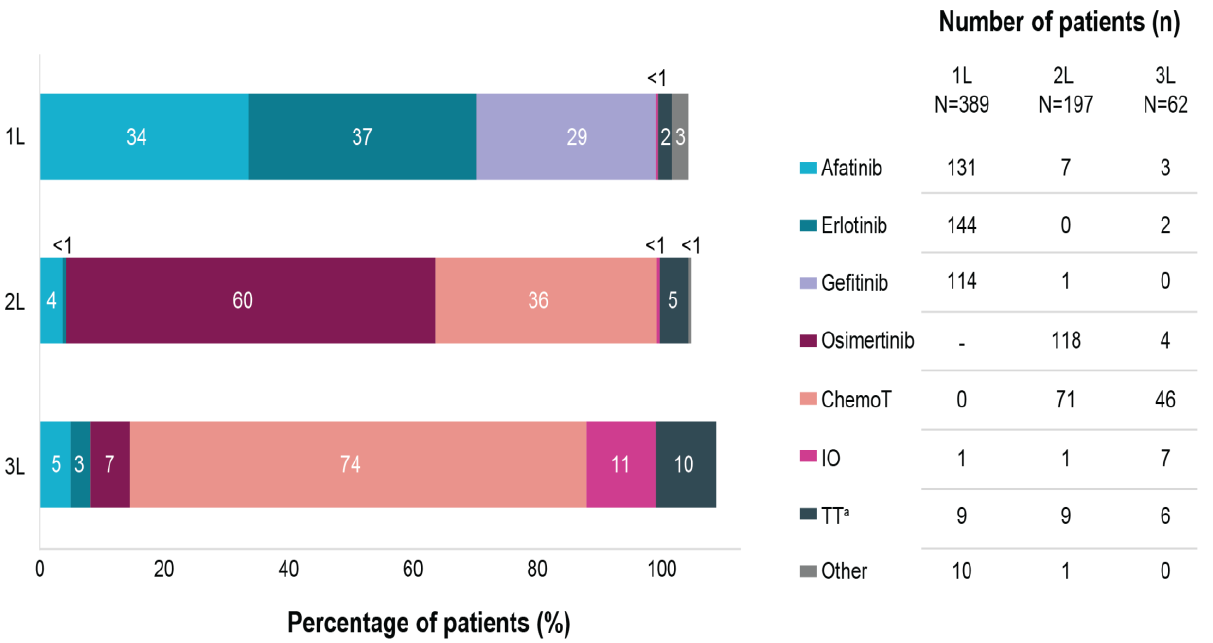
Figure 1. Treatment distribution in EGFRm NSCLC patients across first-, second- and third-lines of therapy. Note: multiple therapies could have been selected in one patient. a targeted therapy besides afatinib, erlotinib or gefitinib. 1L, first line therapy; 2L, second line therapy; 3L, third line therapy; N, number of patients initiating each therapy line; n, number of patients receiving specific treatments; ChemoT, chemotherapy; EGFRm, epidermal growth factor receptor mutation; IO, immunotherapy; NSCLC, non-small cell lung cancer; TT, targeted therapy; -, not applicable at the time of our study.